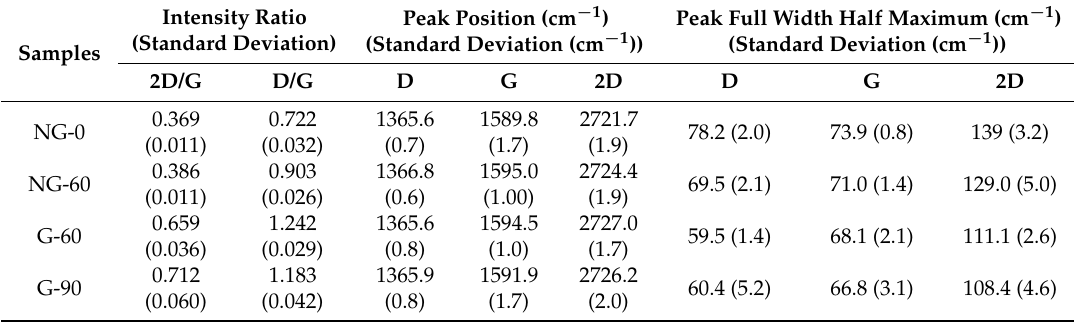
Table 3. Average Raman fit parameters and parameter ratios for four undoped and doped multilayer graphene samples with different post-annealing durations. The standard deviation for each parameter is in